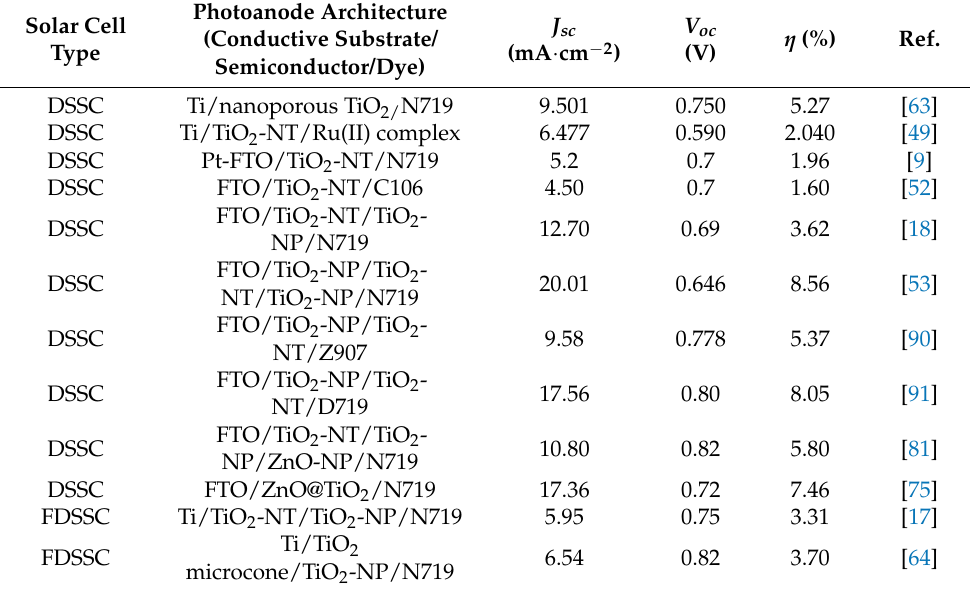
Table 1. Optimized photoanode architectures, short-circuit current densities ( J SC ),